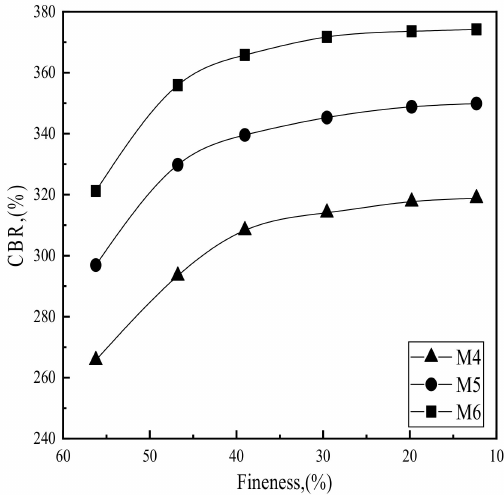
Figure 4. CBR value of cement–PG-stabilized soil with di ff erent PG fineness.